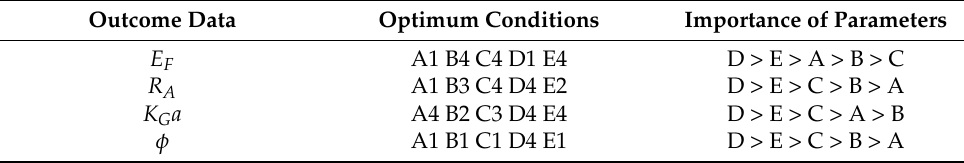
Table 6. Optimum conditions and importance of